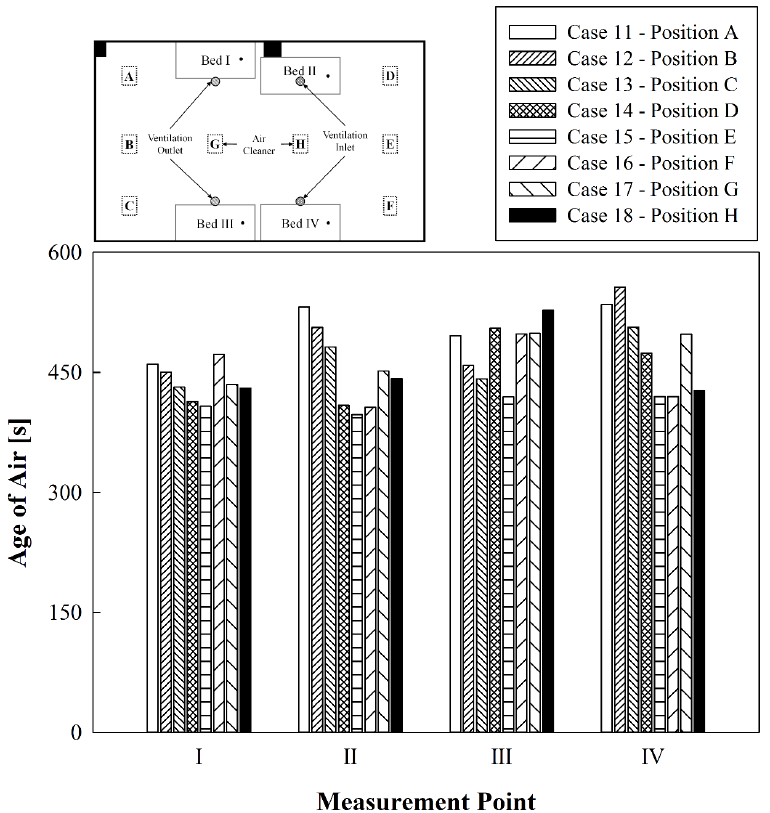
Figure 8. Comparative results of the age of air at locations of the air cleaner while operating the ventilation system. ventilation